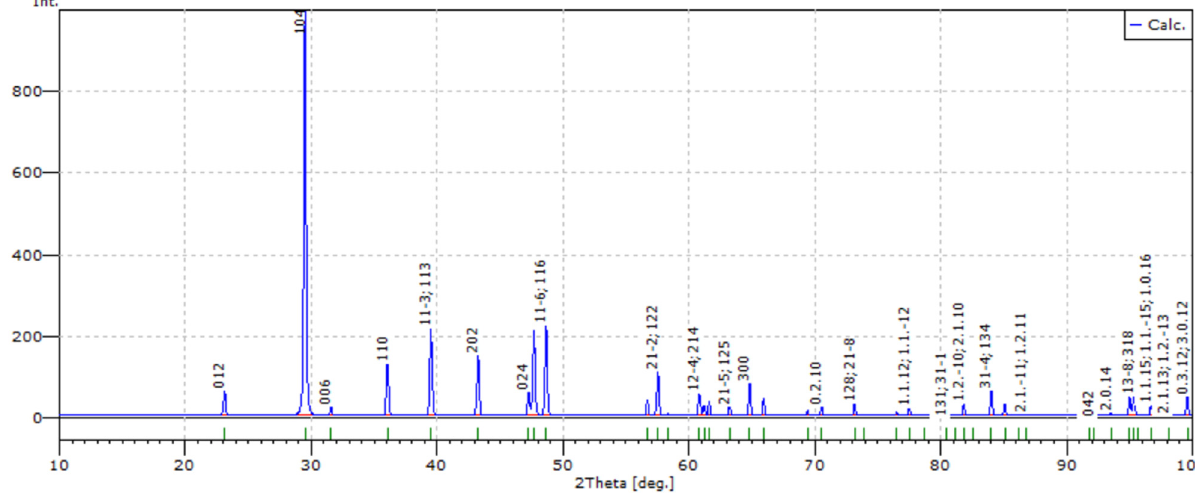
Figure 4: Numerically simulated di ff ractogram of freshly deposited precipitate. Table 7: Network constants and atom coordinates of the atoms of precipitated deposit taken after 3 days Network